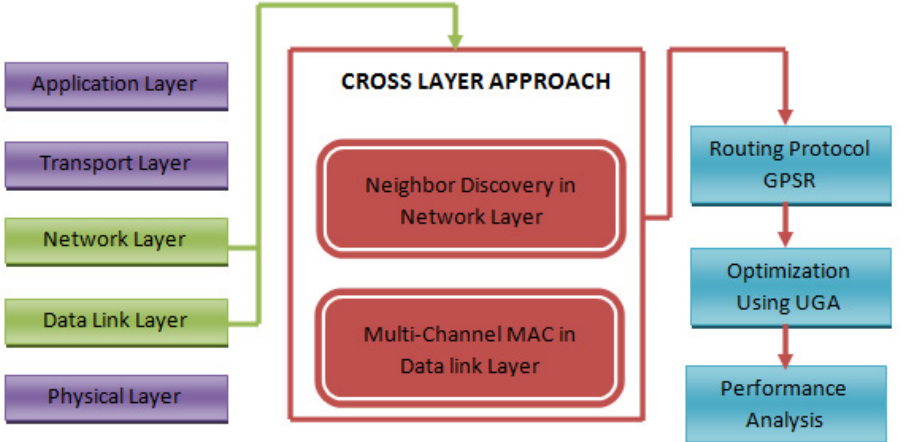
Figure 1. System Architecture of MNUG-CLA Approach.